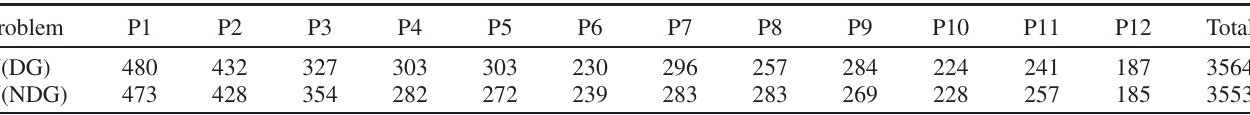
TABLE I. Number of students included in the analysis for each problem. We only included students who answered both the problem and the survey question.